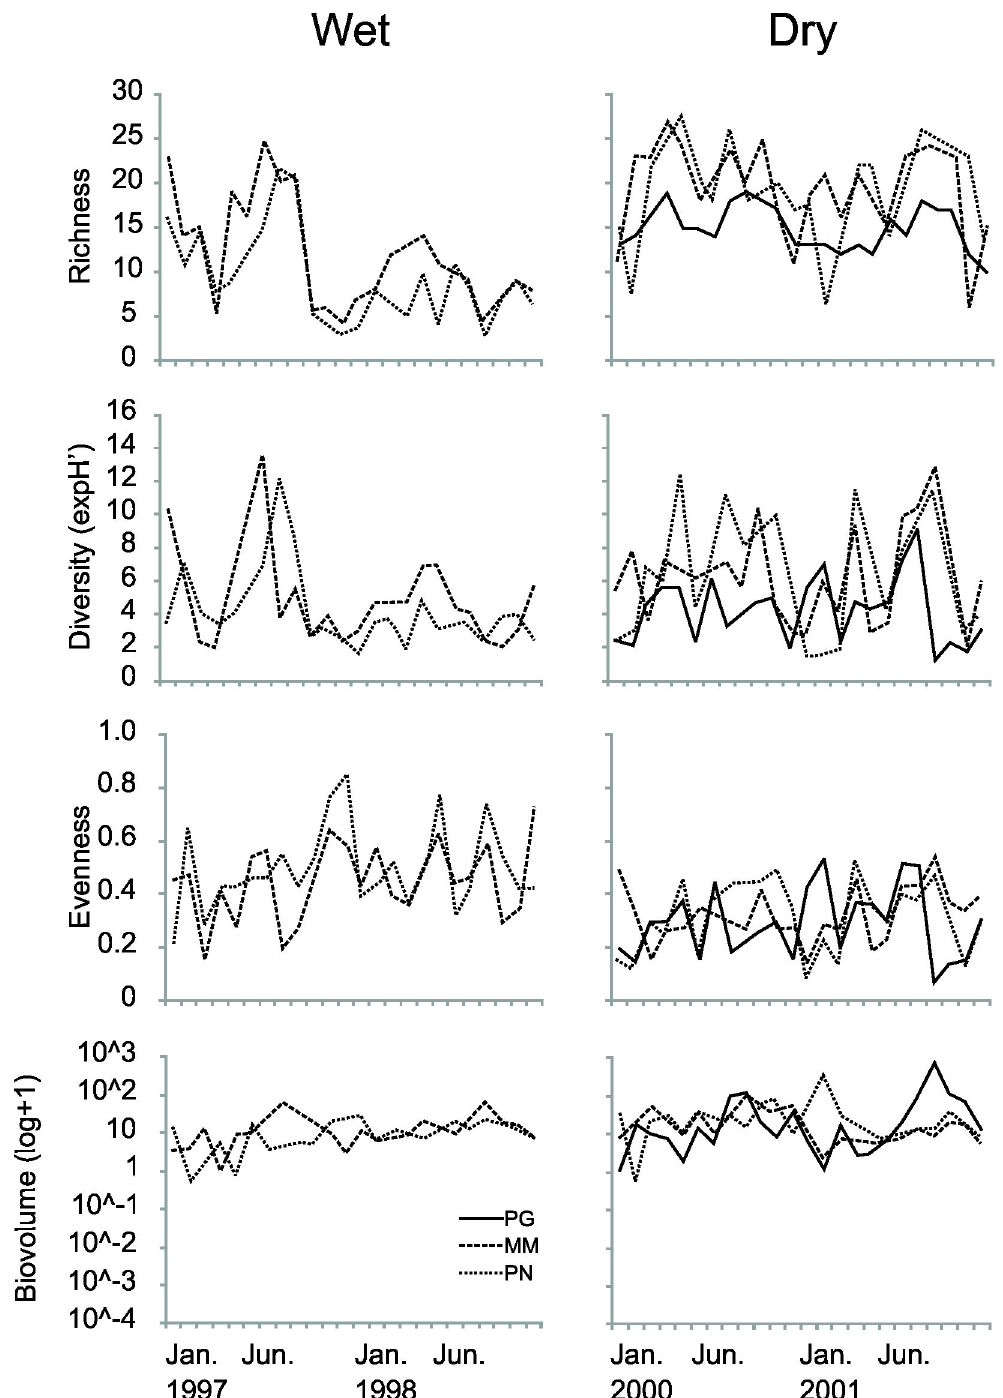
Figure 2. Temporal patterns of phytoplankton community metrics (taxon richness, exponentiated Shannon-Wiener diversity, evenness, and total biovolume) for the three study sites in the wet (left column) and dry (right column) state.